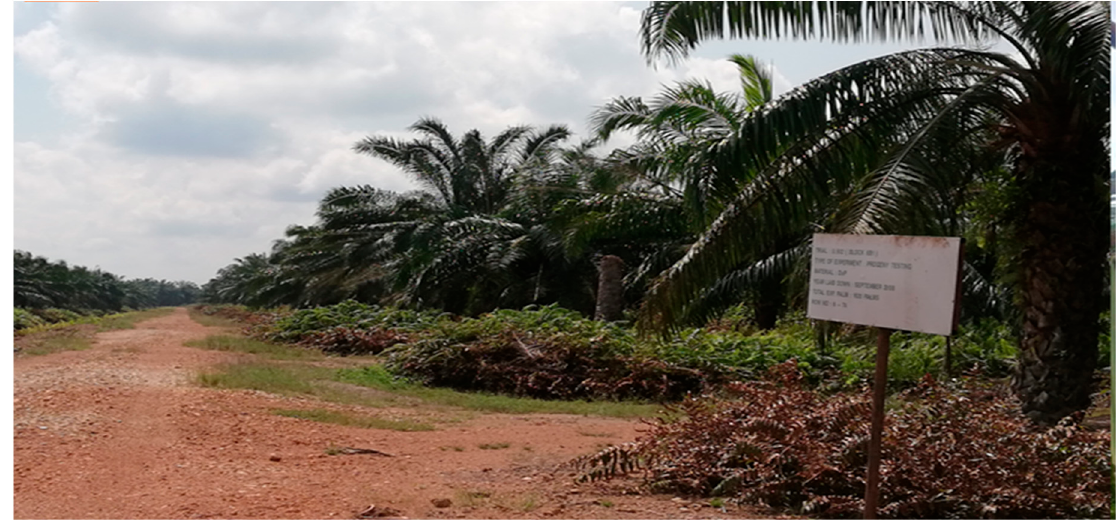
Figure 1. Malaysian Palm Oil Board (MPOB) experimental palms (biparental dura × pisifera hybrids) at Trial 0.502, Teluk- Intan research station, Malaysia.